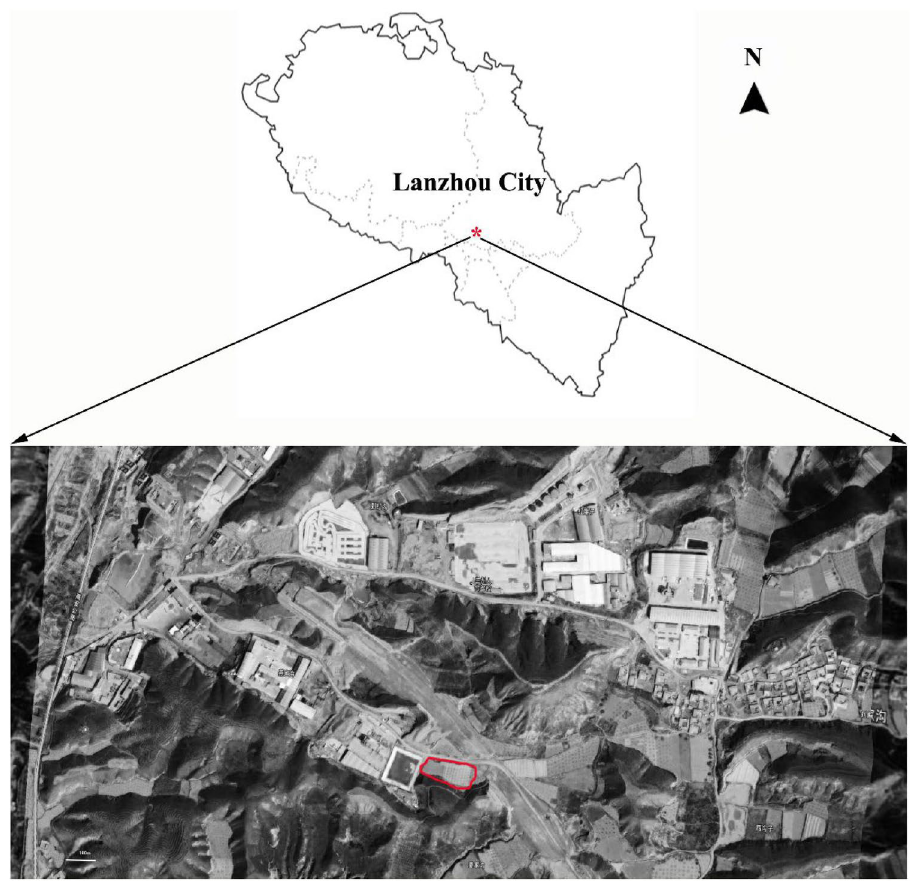
Total nitrogen (g pH kg –1 )